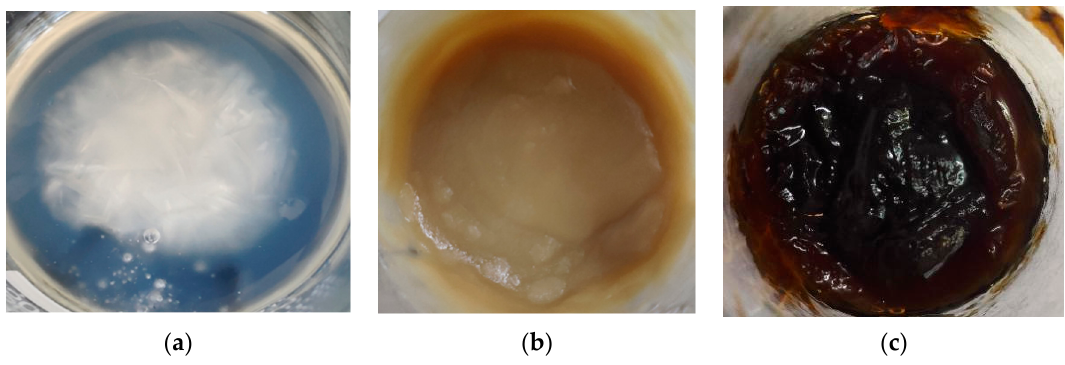
Figure 1. Wood fiber gel material. ( a ) Cellulose gel; ( b ) Hemicellulose gel; ( c ) Lignin gel.